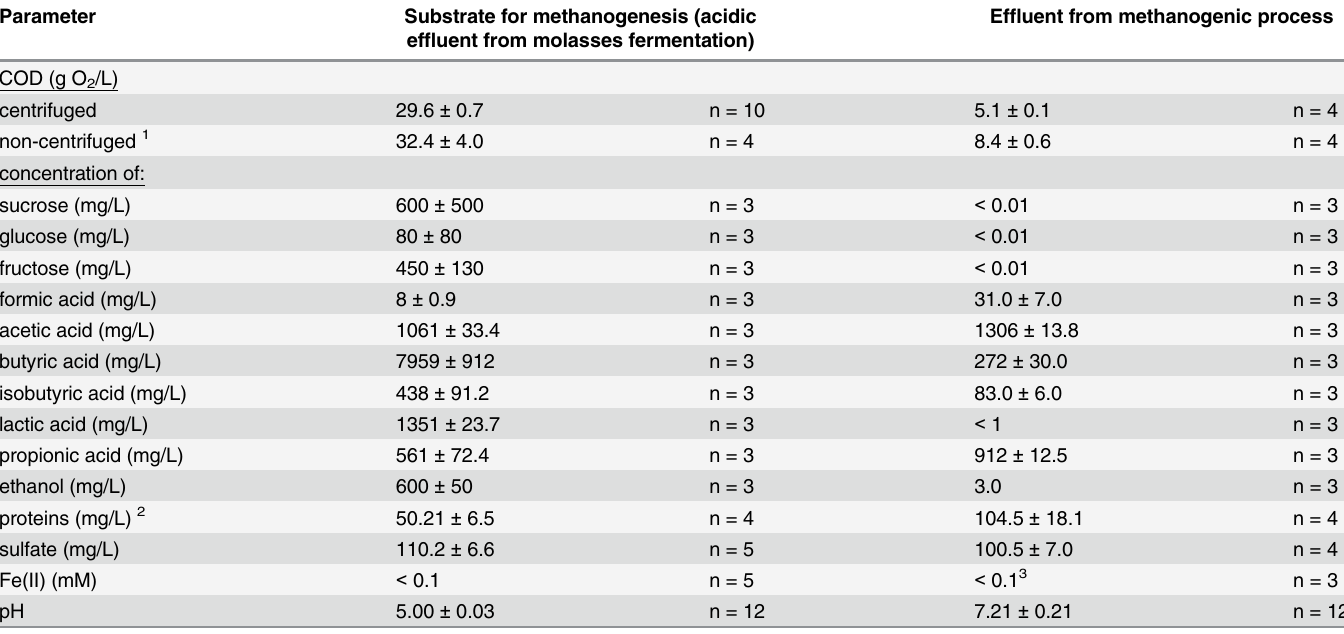
Table 1. Characteristics of the acidic effluent resulting from molasses fermentation used as the substrate for methanogenesis, and the effluent from the methanogenic process. Parameter